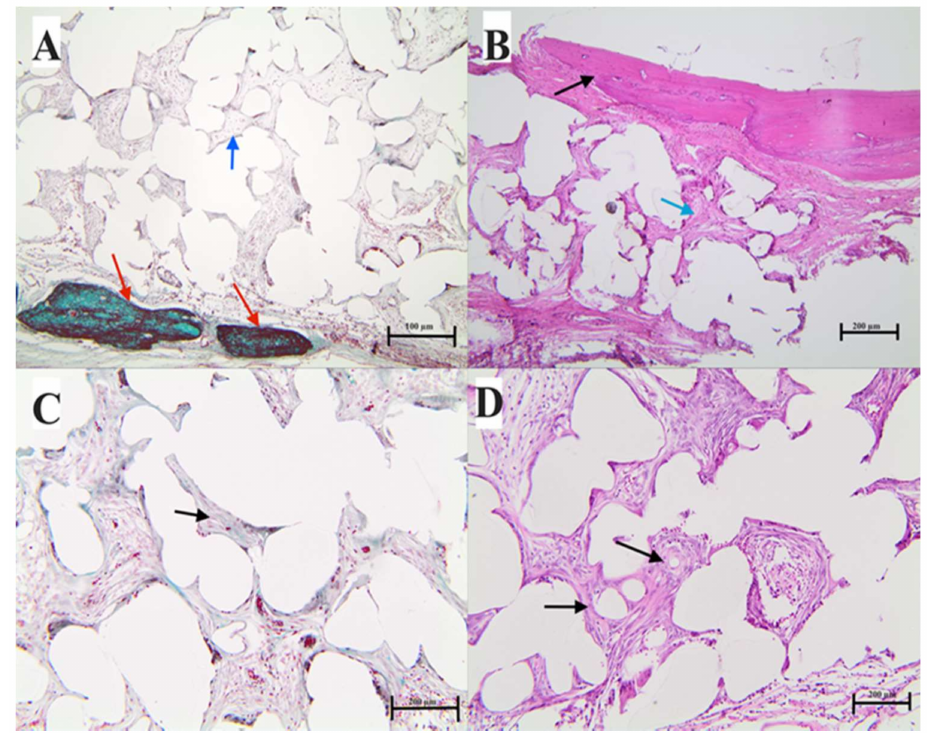
Figure 14. H&E and Masson’s trichrome staining for non-coated polyethylene disks. Decalcified sections were stained with hematoxylin and eosin (right) and Masson’s trichrome stain (left), demonstrating the area of bone regeneration at the surgical defect using plain polyethylene. ( A , B ) are sections through the area of the peripheral bone defect and the implanted plain non-coated polyethylene. ( B ) Black arrow shows newly generated bone with evidence of active remodeling. The connective tissue is next to the bone, with osteoblastic and pre-osteoblast like cells (see blue arrows). ( C , D ) are sections from the center of the scaffold; the interpore spaces are full of connective tissue that turned into bone in the osteons ( C , D black